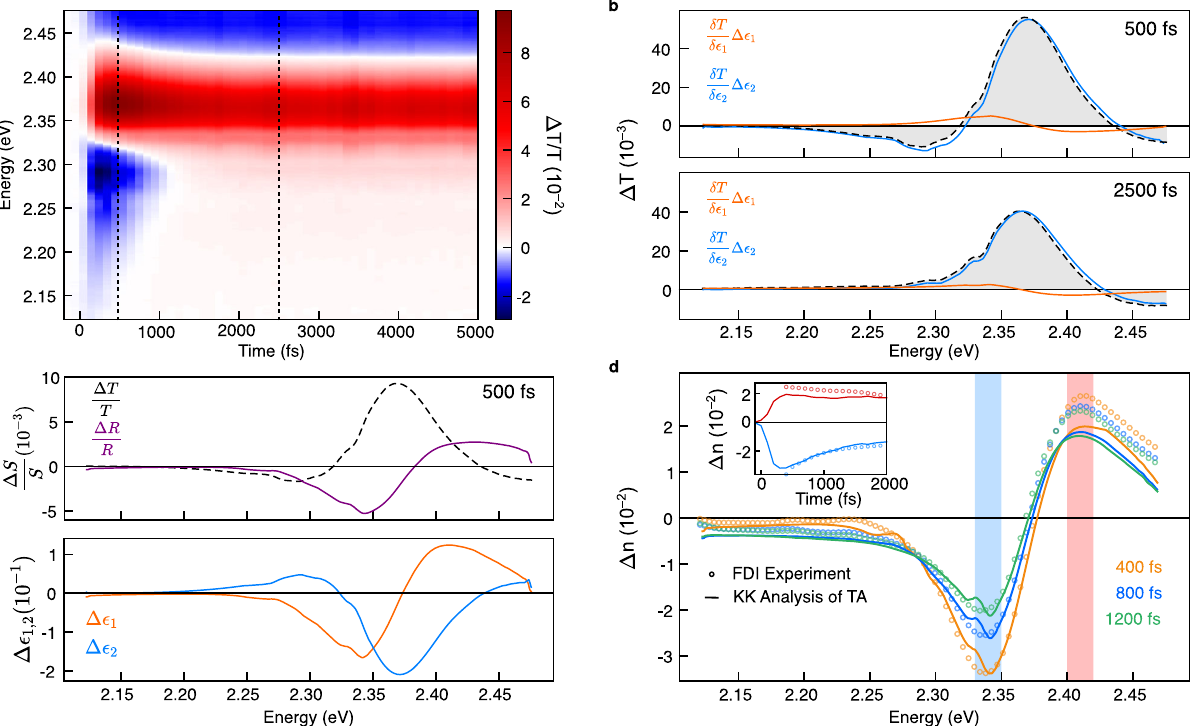
Fig. 2 Extraction and benchmarking of the picosecond transient dielectric function of CsPbBr3. a Broadband transient transmission spectrum of CsPbBr 3 . b Contribution of changes in the real and imaginary part of the dielectric function to the measured transient transmission at 500 and 2500 fs, demonstrating that transient transmission is a very sensitive measure of changes in the underlying imaginary dielectric function. c The transient dielectric function and normalised transient spectra S( ω ) computed from the measured differential transmission at 500 fs demonstrating that neither the transient re fl ection and transmission capture the spectral information of Δ ε 2 exactly. d Comparison of the extracted Δ n( ω ) with that retrieved from a time-resolved frequency domain interferometry (FDI) experiment on the same sample at the same excitation density demonstrating quantitative agreement. Inset: Comparison of Δ n( ω ) kinetics over the two spectral bands